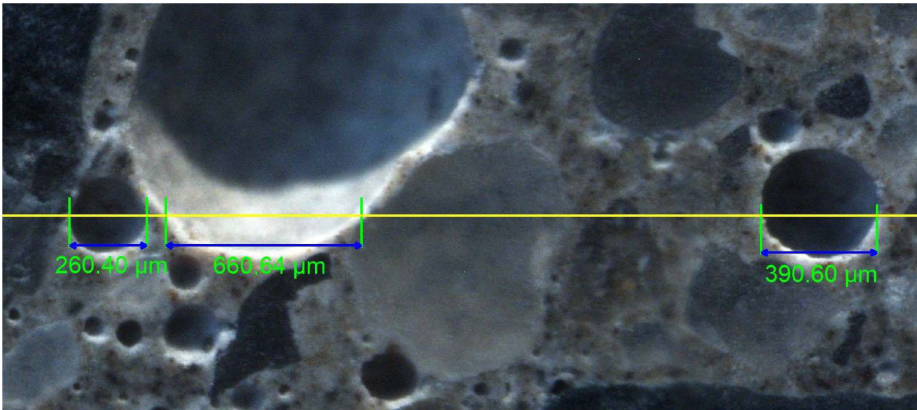
Figure 1. Surface of concrete with a marked traverse